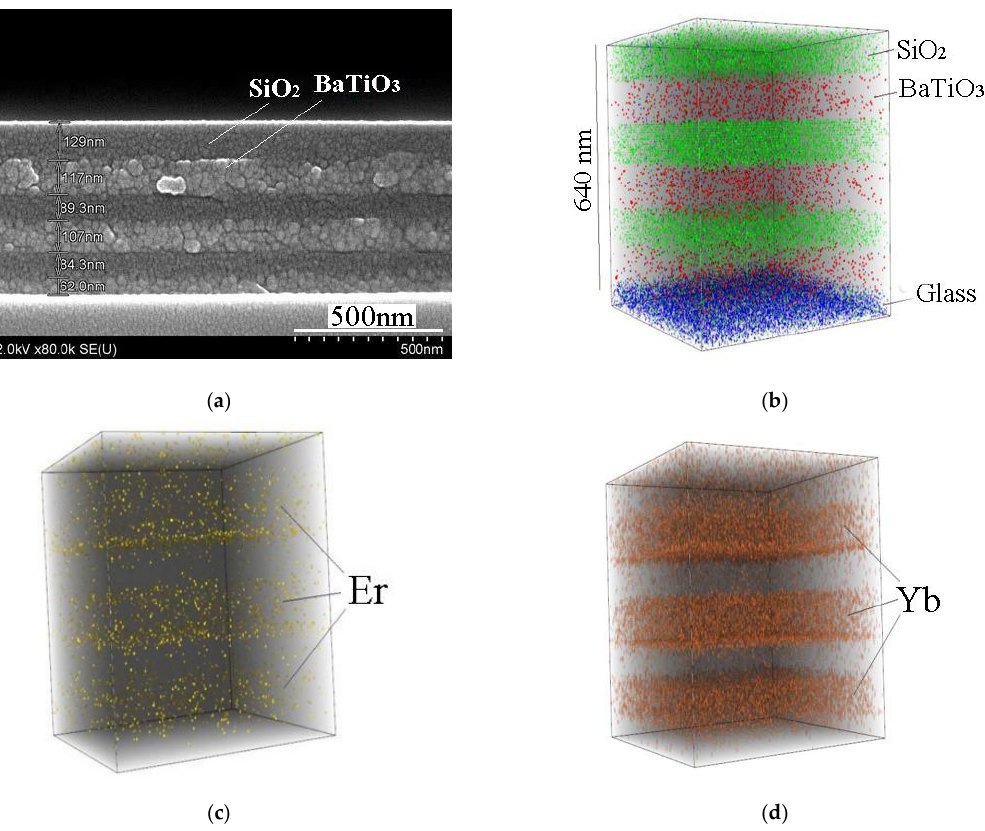
Figure 6. SEM image ( a ) and 3D SIMS images ( b – d ) of the BaTiO 3 :(Er,Yb)/SiO 2 Bragg reflector on a glass substrate (sample E) after annealing at 450 °C for 30 min in air. Further, the same conditions of sols deposition and annealing of the xerogel layers were applied to fabricate a microcavity structure on a fused silica substrate (sample F). The total thickness of the microcavity was about 1.5 µm after heat treatment at 450 °C (Figure 7a) and about 1.4 µm after additional annealing at 600 °C (Figure 7b). We have to note, that contrary to thick BaTiO 3 xerogel films annealed at 800 °C [16] and xerogel pow- der annealed at 1000 °C, thin BaTiO 3 xerogel films of microcavity structures annealed at 450 °C and 600 °C are X-ray amorphous.